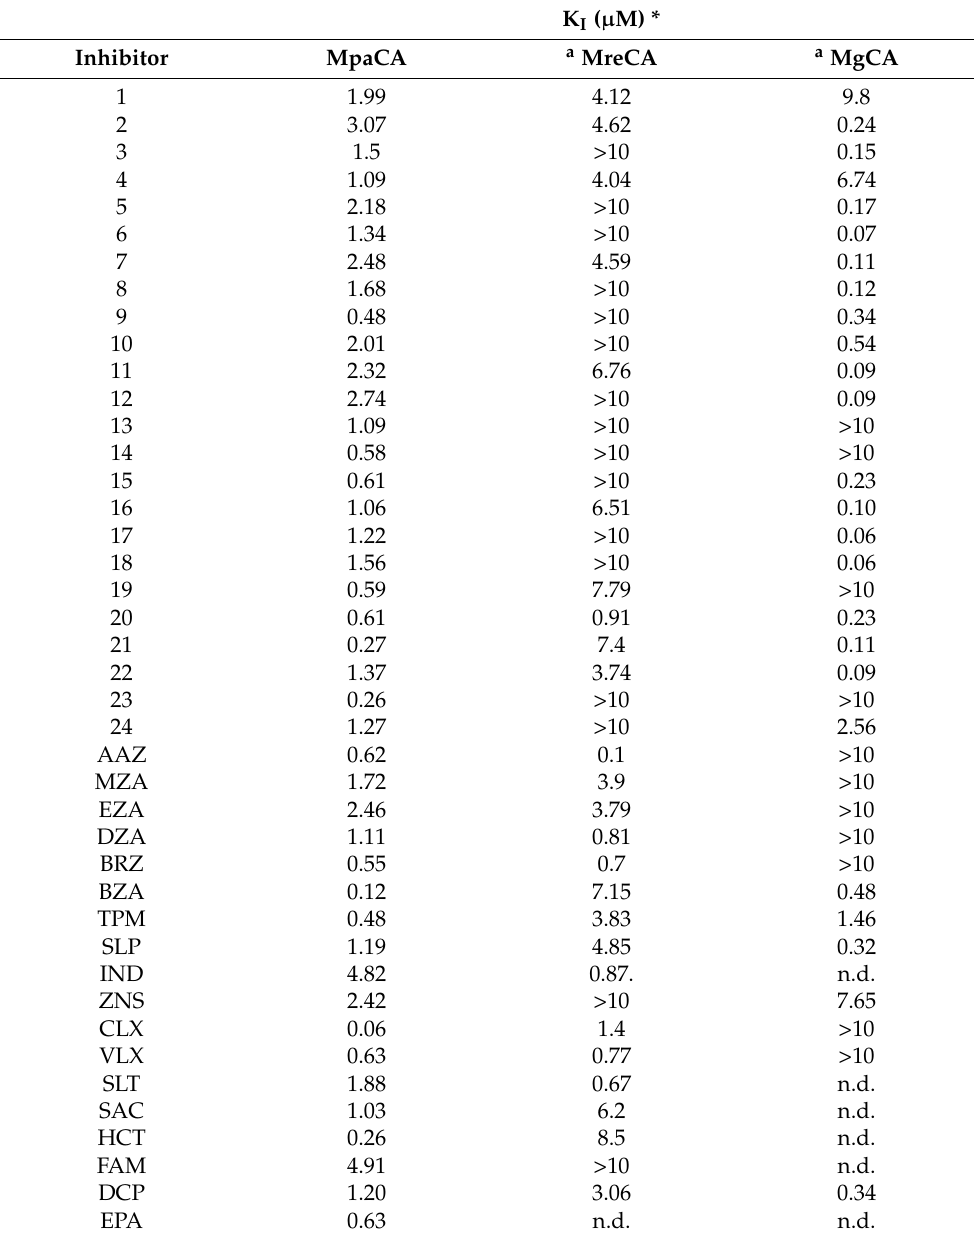
Table 2. Inhibition profile of MpaCA, MreCA, and MgCA with respect to forty-one sulfonamide and one sulfamate